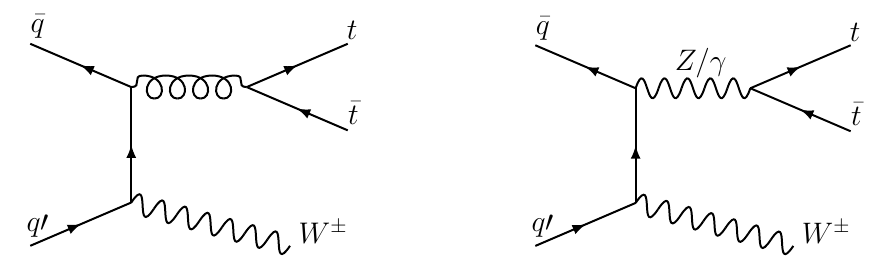
Figure 1 . Representative diagrams for the Born (cid:22) qq 0 ! t (cid:22) tW (cid:6) amplitude. The left diagram is of O ( (cid:11) s (cid:11) 1 = 2 ), the right one is of O ( (cid:11) 3 = 2 ).